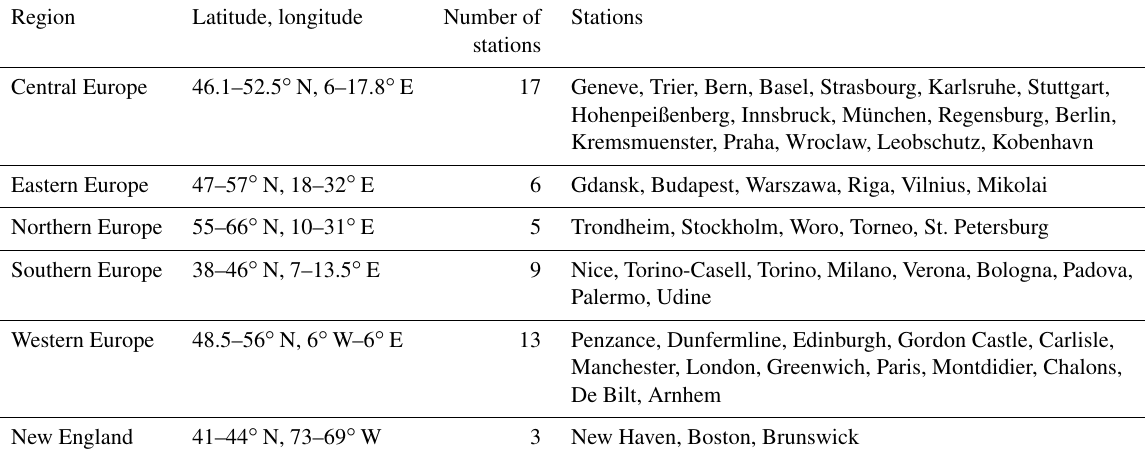
Table A2. Overview of the different stations which are used in the compilation of the regional and seasonal station mean.